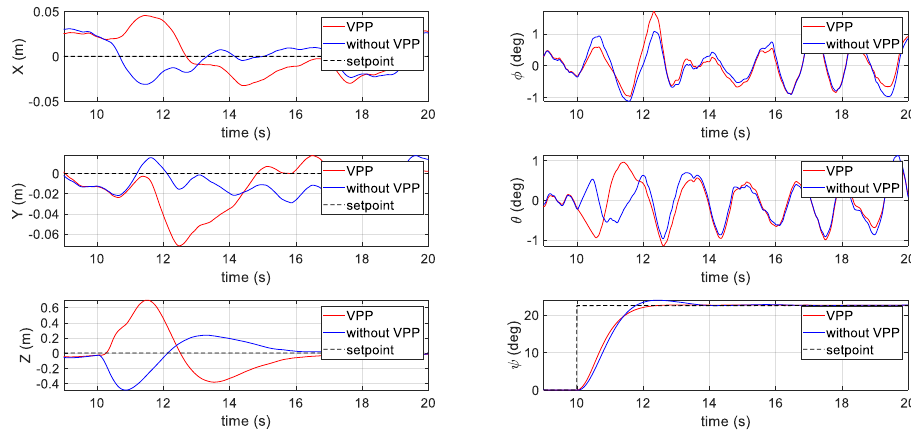
Figure 7. Results of the first scenario with a yaw step command in the simulation.